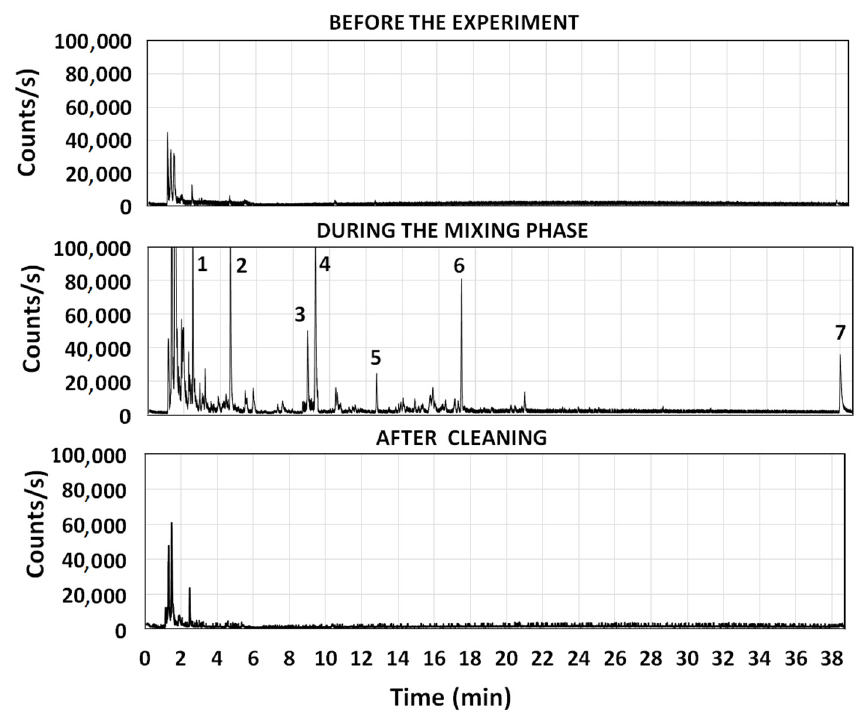
Figure 14. GC-MS profiles obtained by collecting VOCs before the room was polluted with cigarette smoke ( t = t IN ), at the end of the mixing phase ( t ∼ = t 0 ) and after 3 h of cleaning (( t ∼ = t 0 + 3 h ). The SANINDOOR prototype was used as an air cleaner. Peaks identified in the samples are: (1) benzene, (2) toluene, (3) (m + p) xylenes, (4) ethylbenzene, (5) α -pinene, (6) D-limonene, and (7) 3,5-dimethyl cyclohexanol.